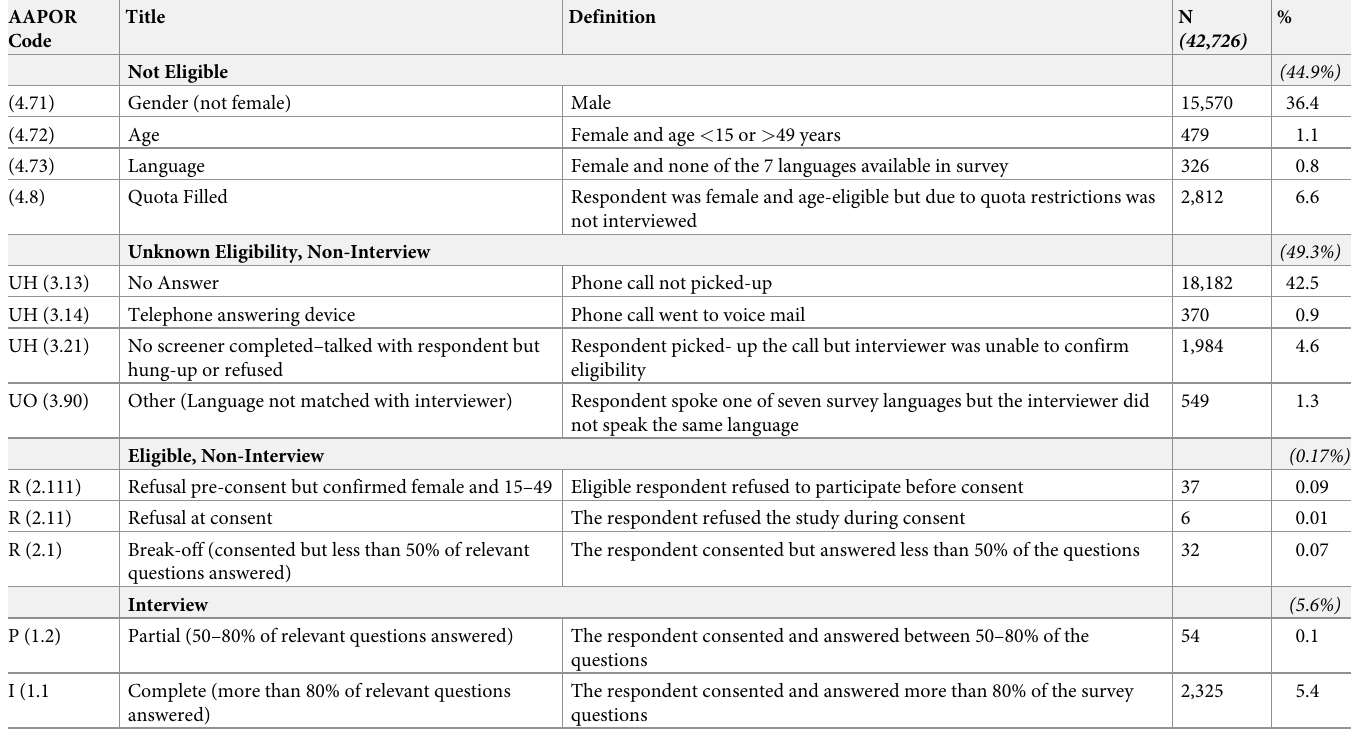
Table 2. Final disposition codes for RDD survey, among valid phone